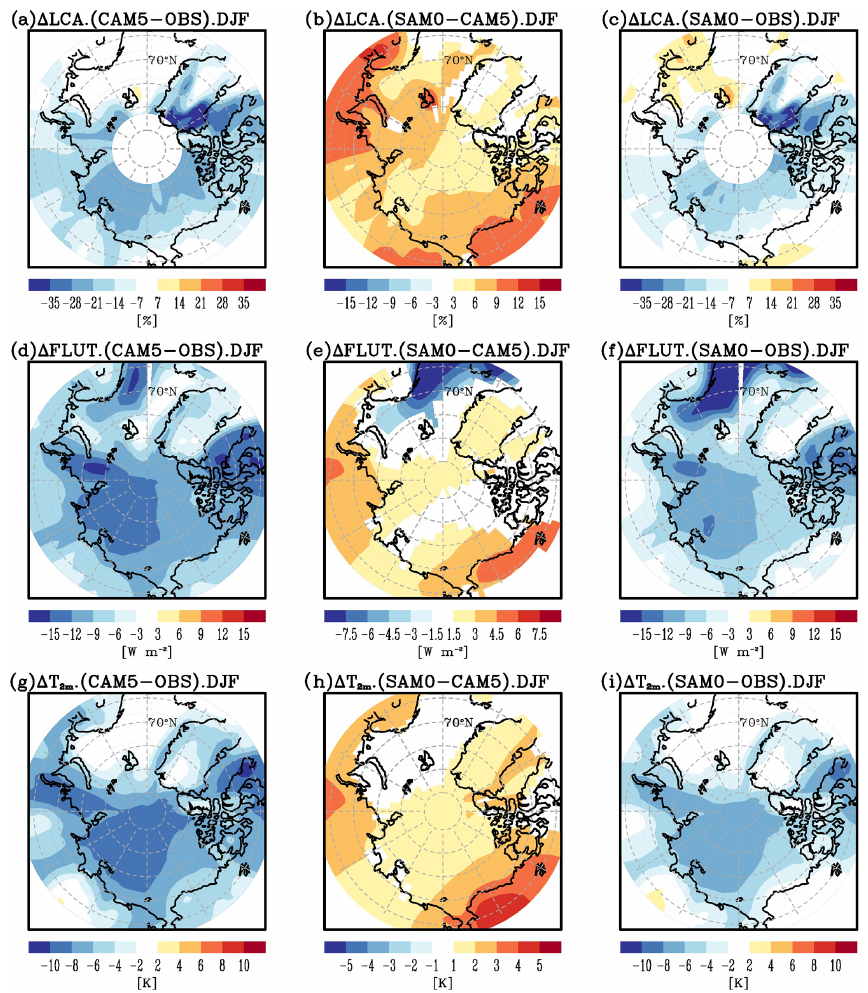
Figure 9. Biases of (a, c) low-cloud fraction (LCA) against the CALIPSO-GOCCP observation, (d, f) upward longwave (LW) radiative flux at TOA (FLUT) against the CERES EBAF observation, and (g, i) near-surface air temperature at a 2m height ( T 2m ) against the ERA-Interim reanalysis during DJF obtained from (a, d, g) CAM5 and (c, f, i) SAM0, and (b, e, h) the differences in each variable between SAM0 and CAM5. The CERES EBAF observations were averaged from 2000 to 2013, the ERA-Interim reanalysis was averaged from January 1979 to February 2015, and the model results are the means of AMIP simulation results for 36 years from January 1979 to February 2015. Shaded areas in (b) , (e) , and (h) exceed the 95% significance level from the Student t